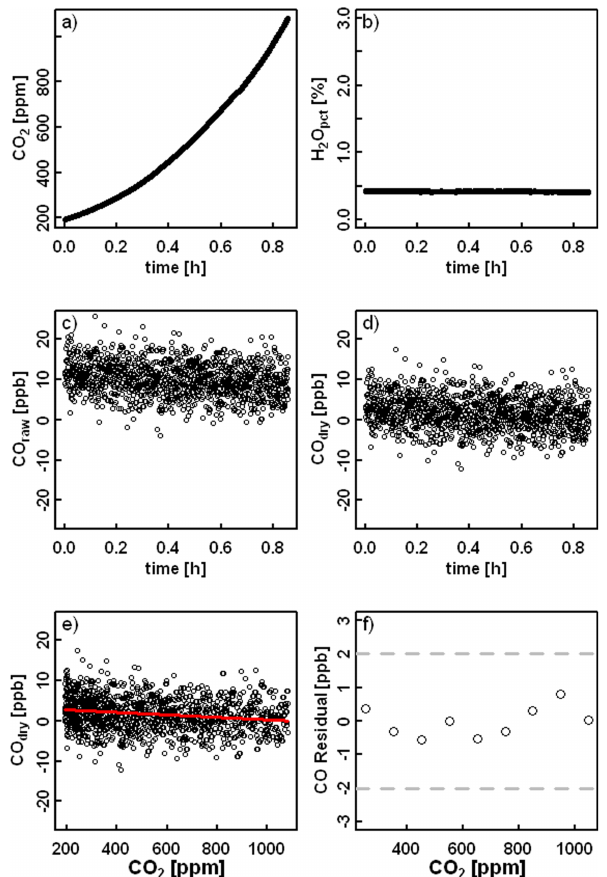
Fig. 6. Experimental data of a CO 2 dependence test: (a) the slow change in CO 2 over time; (b) the time series of water vapor; (c) the time series of raw CO; (d) the time series of water-corrected dry CO; (e) dry CO vs. CO 2 , and a linear fit shown by the red line; (f) the 100ppm bin-averaged residuals of the linear fit. Dashed lines indicate the compatibility goals set by the WMO for CO